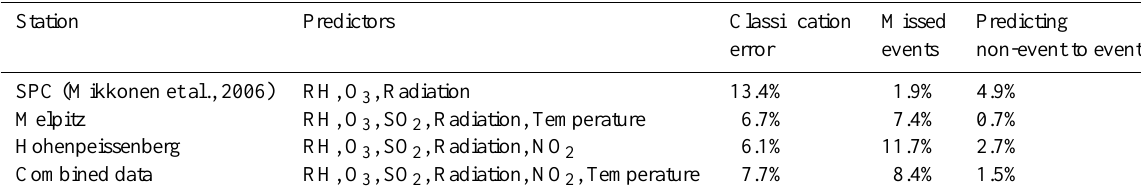
Table 1. Results from Discriminant analysis.